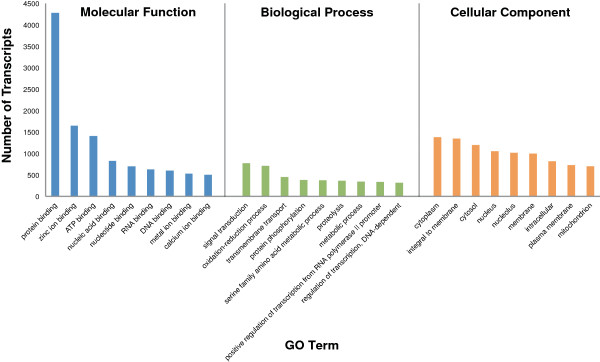
GO annotations. Top 10 represented GO terms for each of the GO categories; Molecular Function, Biological Process and Cellular Component. GO terms annotated by protein similarity to the NCBI non-redundant database and from InterProScan results.